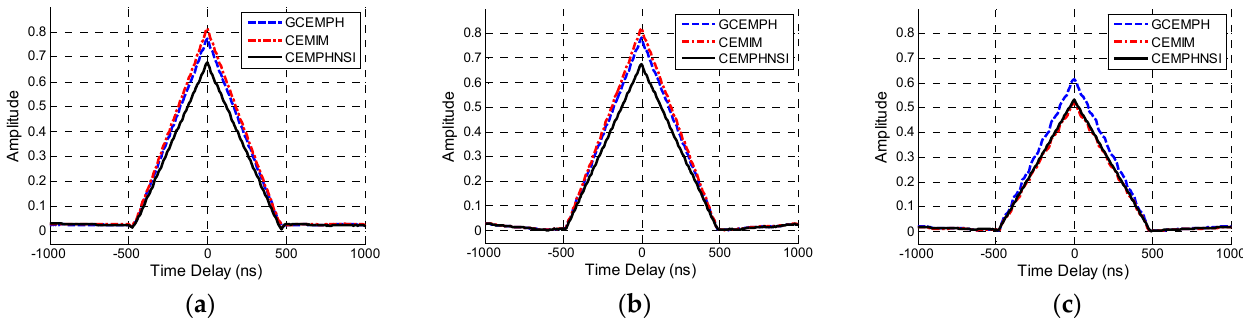
Figure 7. ( a ) The correlation between 3 multiplexing signals and signal s 1 ; ( b ) The correlation between 3 multiplexing signals and signal s 2 ; ( c ) The correlation between 3 multiplexing signals and signal s 3 .